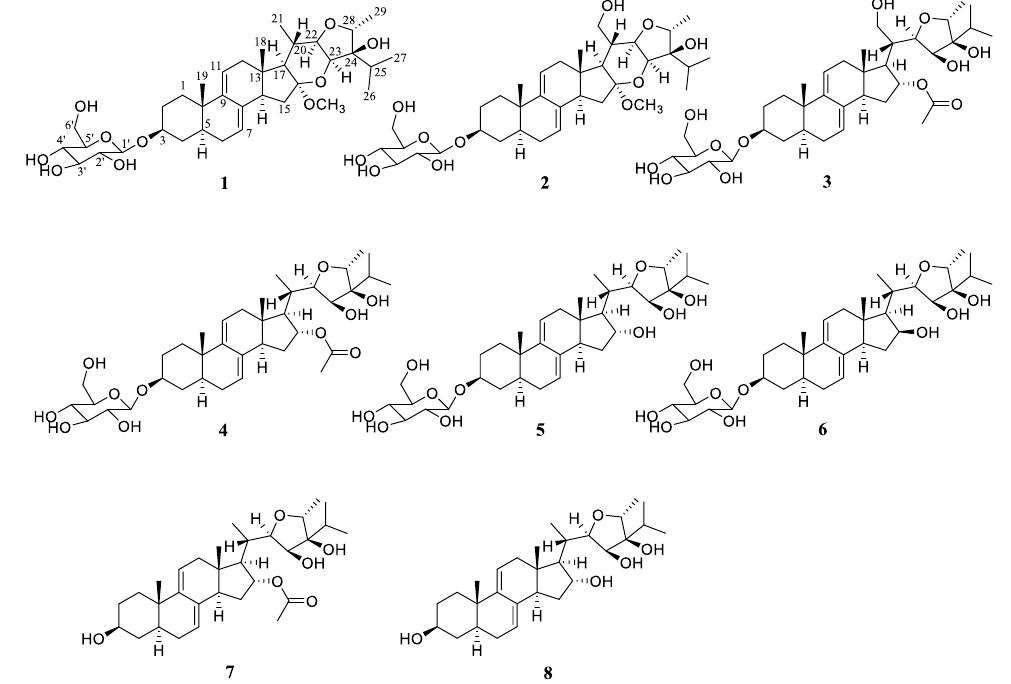
Figure 1. Structures of 1 – 8 isolated from V. amygdalina .